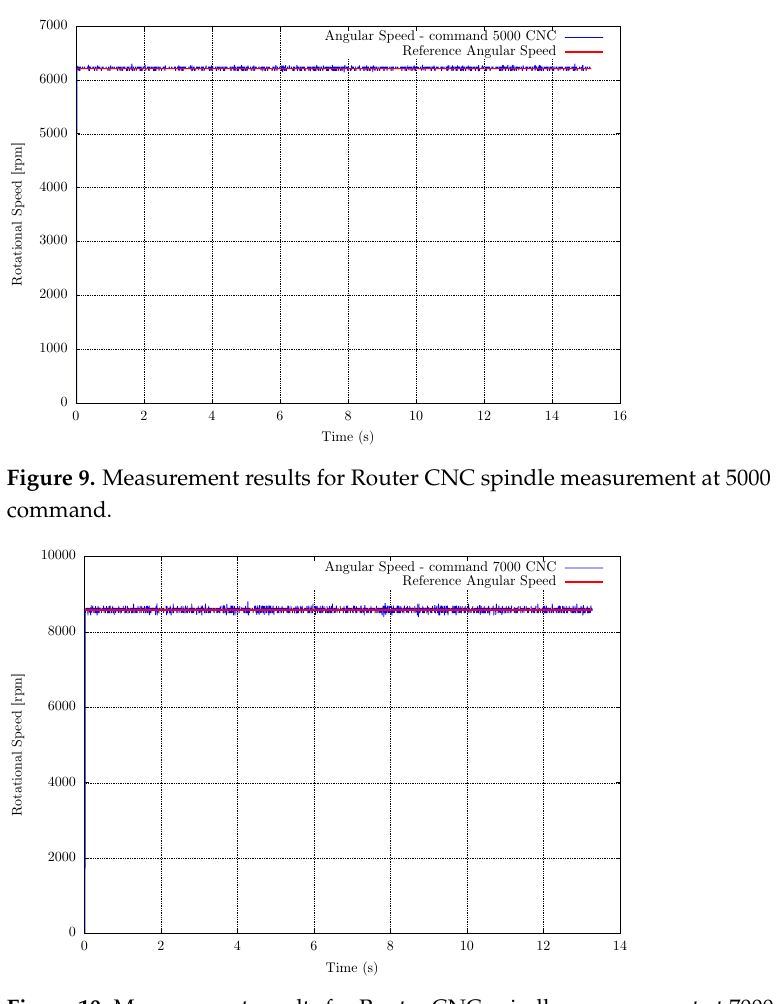
Figure 10. Measurement results for Router CNC spindle measurement at 7000 machining numerical command. Table 4. Results for the MAE for the measurement method experimental evaluations with the Router CNC